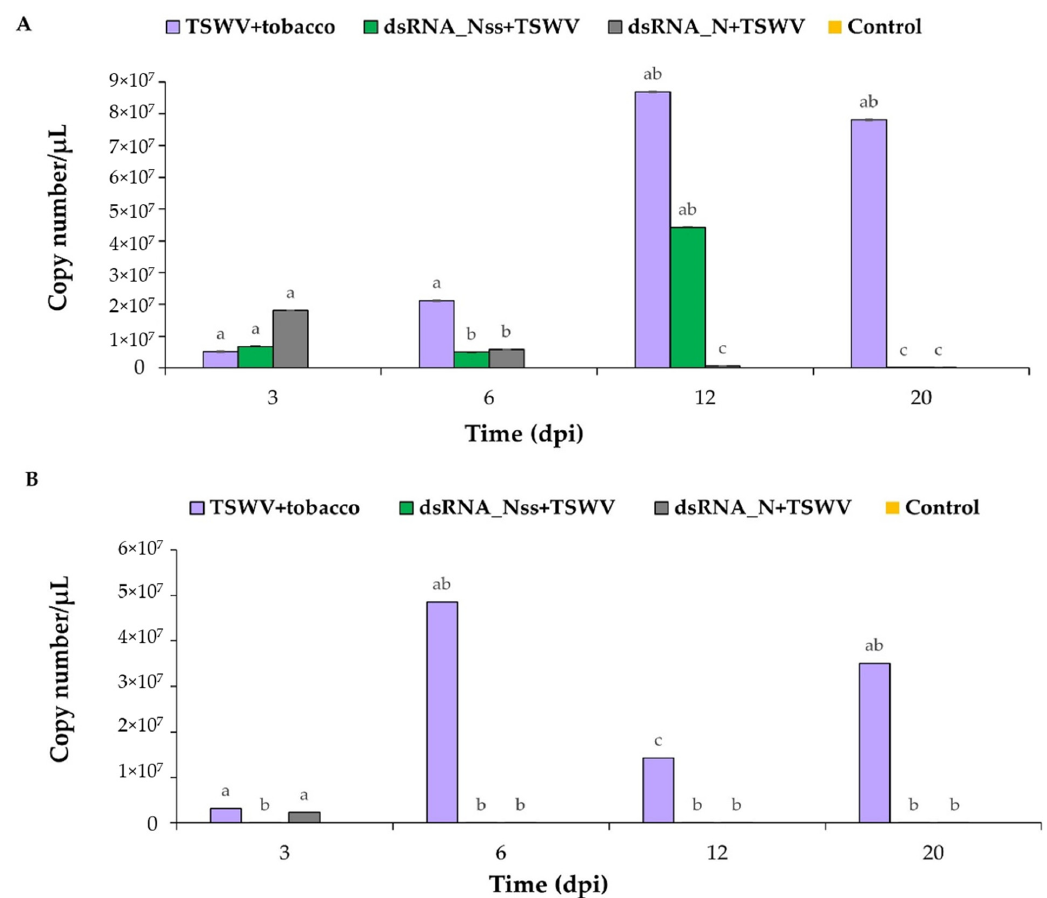
Figure 3. Accumulation of tomato spotted wilt virus (TSWV) in inoculated and younger, non-inoculated leaves of tobacco at different time points. Logarithmic graph of the viral copy numbers of four different treatments (dsRNA_N + TSWV, dsRNA_NSs + TSWV, TSWV+ tobacco, and control. ( A ) TSWV copy number in co-inoculated leaves and ( B ) TSWV copy number in younger, non-inoculated leaves. Different letters indicate statistically significant differences ( p < 0.05) between means. Error bars represent standard